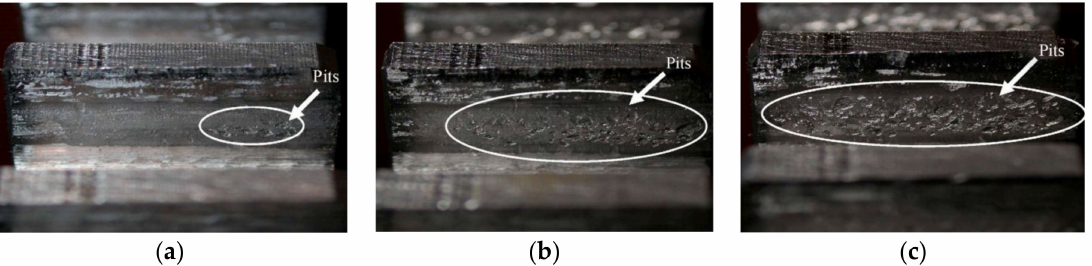
Figure 7. Pitting gear teeth: ( a ) Pitting extending area: 6.3%; ( b ) Pitting extending area: 27.8%; ( c ) Pitting extending area: